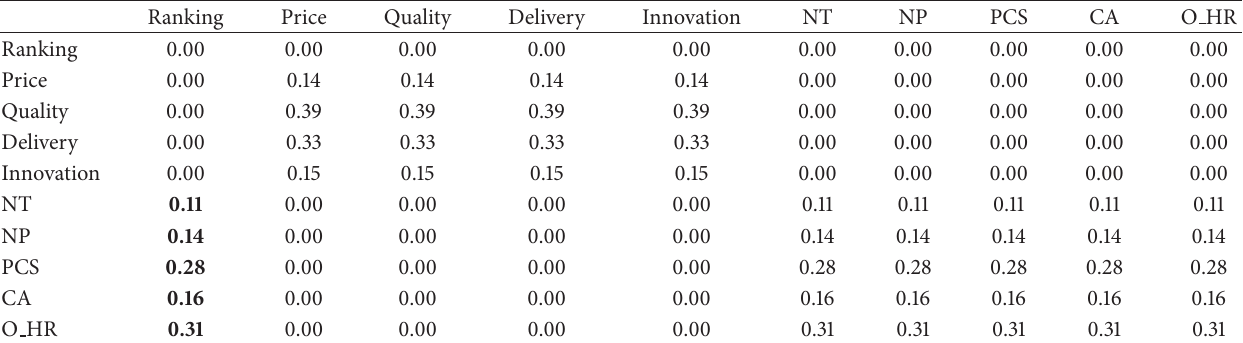
Table 14: Matrix limit corresponding to the decisions of decision agent 5.